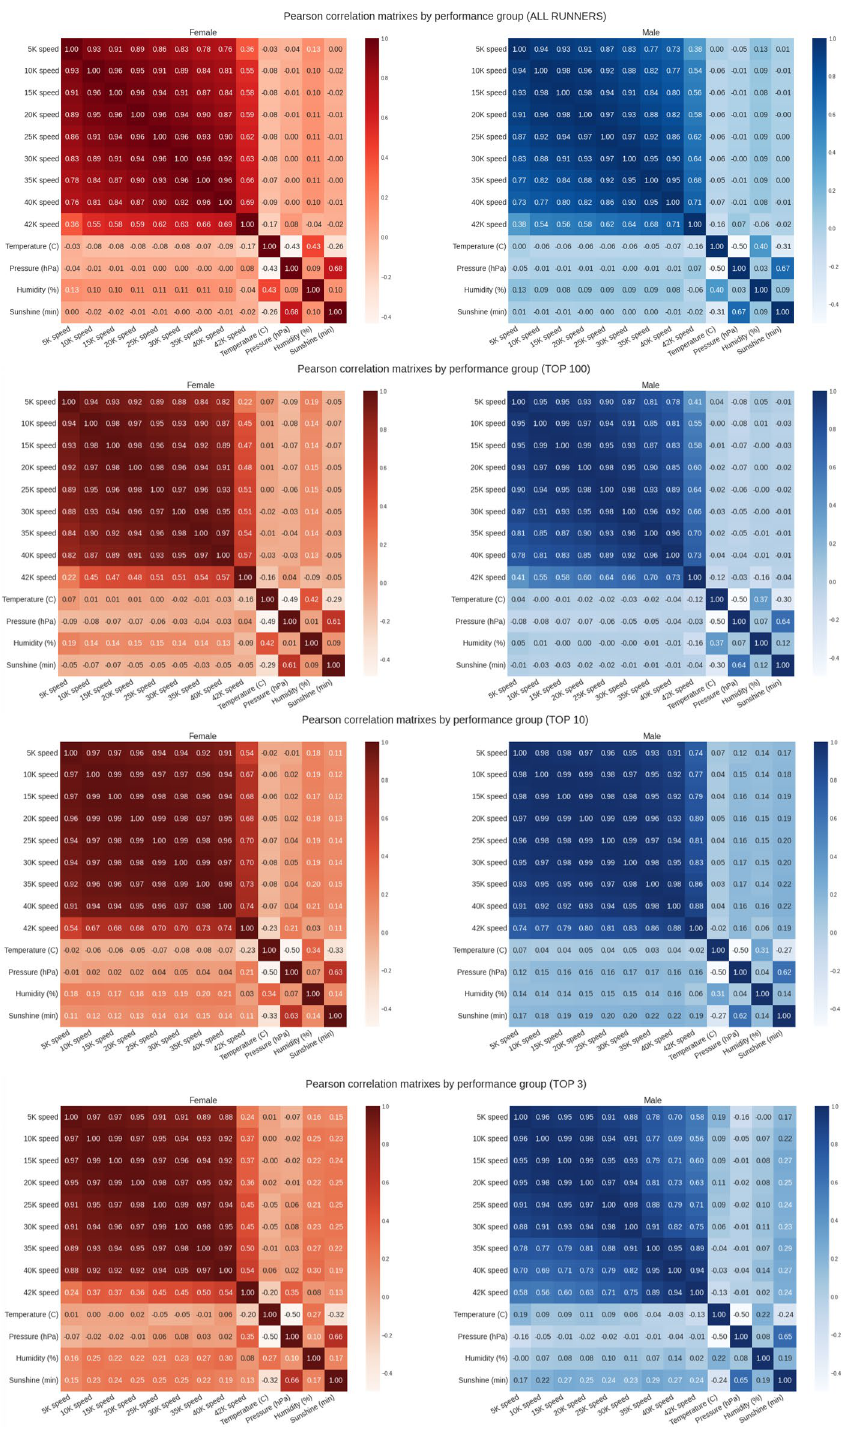
Figure 7. Pearson correlation matrixes by performance